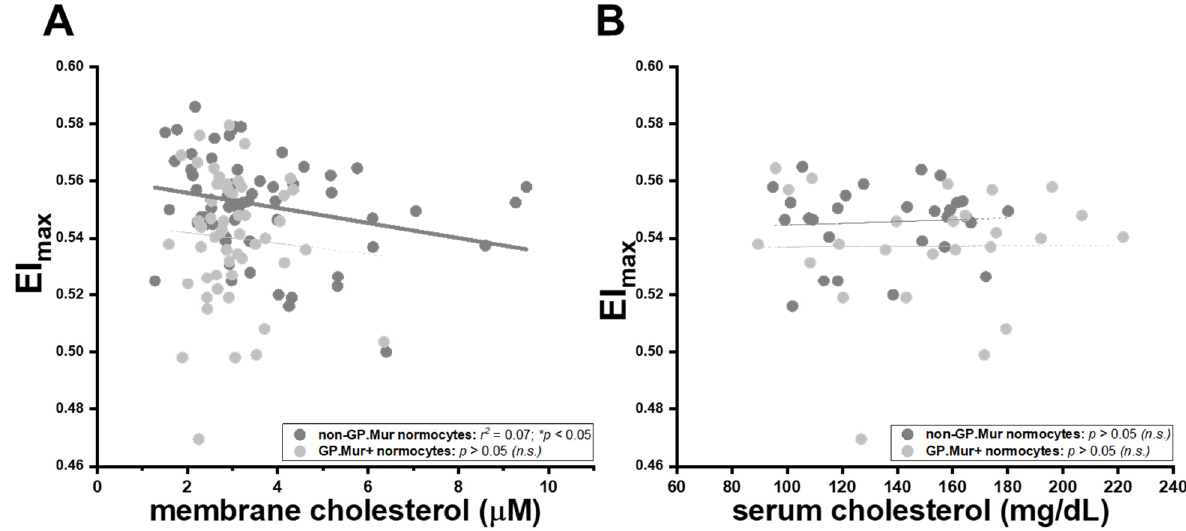
Figure 3. The rigidifying effects of membrane cholesterol on red cell deformability were significant in non-GP.Mur RBCs but not in GP.Mur+ RBCs. Each dot represents the data of a subject with normal RBC sizes. The impacts of ( A ) membrane cholesterol and ( B ) serum cholesterol on maximal elongation indices (EI max ) are presented. Significant linear fitting ( * p < 0.05) is presented using a solid line, poor or failed linear fitting ( p > 0.05) in thin dashed lines. n.s ., not significant. We also observed lower membrane cholesterol levels in GP.Mur+ than in non-GP.Mur